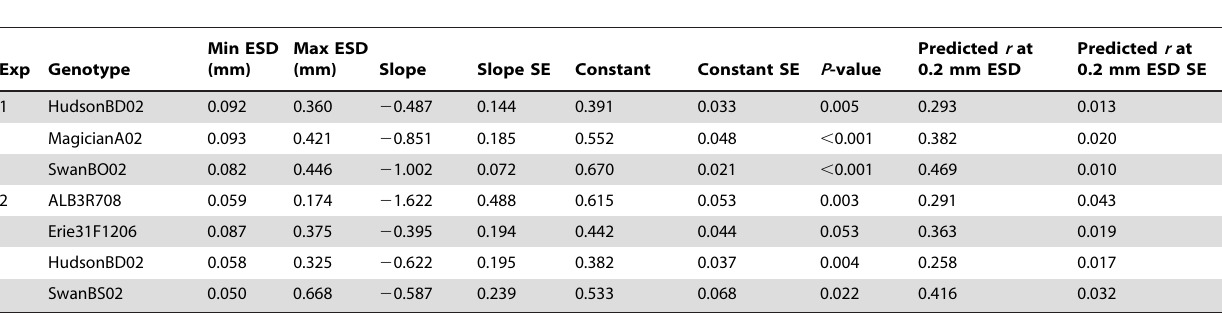
Table 1. Summary statistics for relationships between Microcystis aeruginosa colony growth rate and initial equivalent spherical